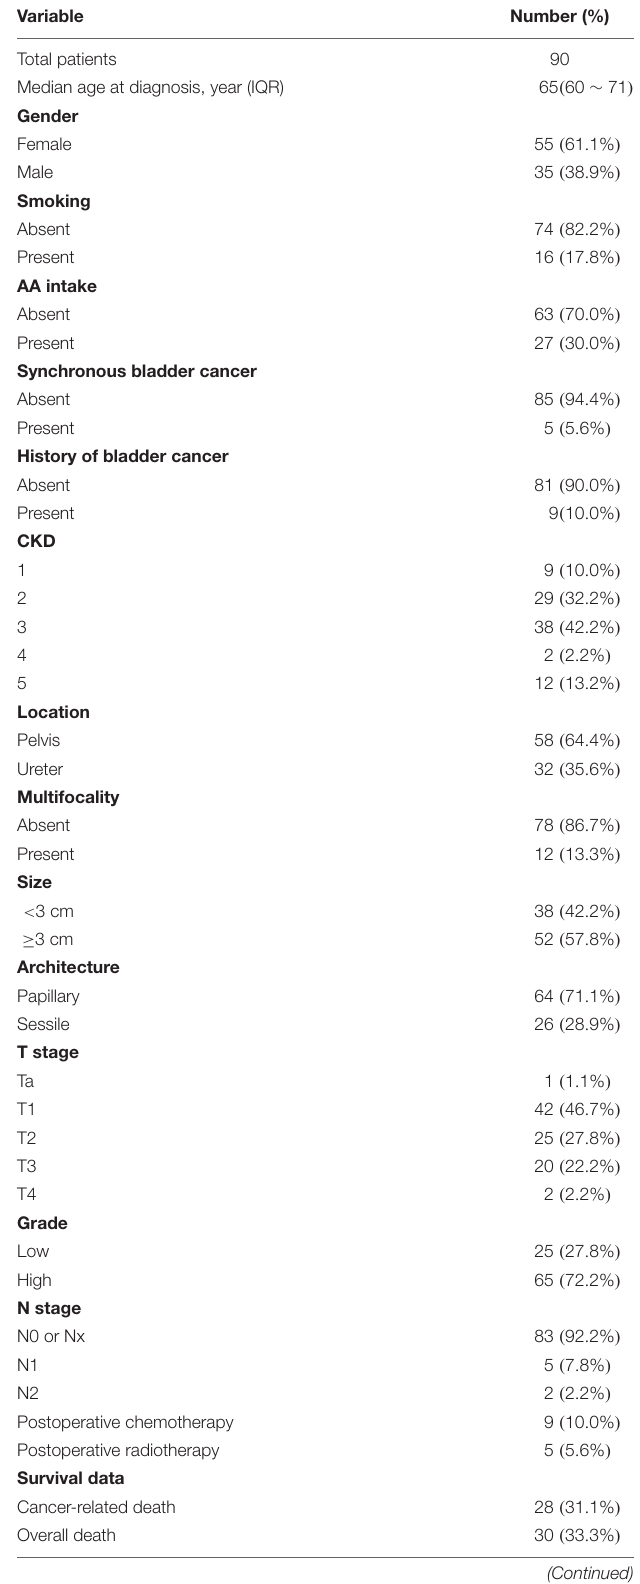
TABLE 1 | Clinicopathological characteristics of 90 UTUC